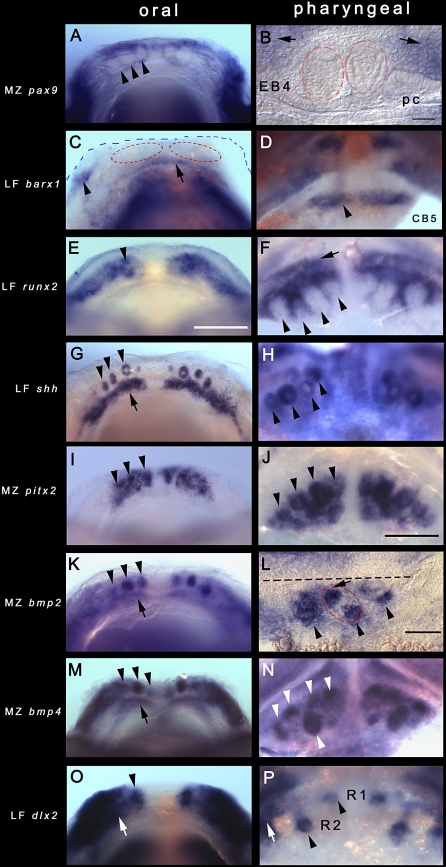
A Dental Gene Network Exhibits Conserved Expression in Oral and Pharyngeal Teeth(A, C, E, G, I, K, M, and O) show gene expression in the oral dentition, all dorsal views of the lower jaw. (D, F, H, J, N, and P) show dorsal views of the developing lower pharyngeal dentition; (B and L) are coronal sections through the pharyngeal teeth. M. zebra (MZ) (A, B, and I–N) and L. fuelleborni (LF) (C–H, O, and P) are represented here at the three to four oral tooth stage (∼6–7 dpf); the pharyngeal dentition develops ahead of the oral teeth, and so at this time point there are approximately seven pharyngeal teeth per pharyngeal quadrant.(A and B) show pax9 expression in MZ. (A) In the lower oral jaw, pax9 marks mesenchymal cells surrounding teeth (black arrowheads). (B) shows a coronal section showing upper pharyngeal teeth with pax9 lateral to (black arrows) but not associated with teeth (red dashed circles). Scale bar in (B) represents 20 μm. EB4, epibranchial 4; pc, pharyngeal cavity.(C and D) show barx1 expression in LF. (C) In the lower oral jaw (outlined in blue dashes), barx1 is expressed in a band of mesenchymal cells (black arrow) lingual to the tooth sites (red dashed regions), and also in lateral cell clusters (black arrowhead) away from tooth sites. (D) barx1 is localized to mesenchymal cells underlying tooth sites in developing lower pharyngeal jaw (CB5, black arrowhead). CB5, ceratobranchial 5.(E and F) show runx2 expression in LF. (E) runx2 labels both mesenchymal cells of the oral mesiodistal field for tooth competence and mesenchymal cells that surround the epithelial tooth germs (black arrowhead). (F) Equivalent expression is observed in the developing pharyngeal jaw (tooth germs, black arrowheads) and in tooth-competent regions of mesenchyme (black arrow).(G and H) show shh expression in LF. (G) shh is expressed in the epithelial cells of the developing oral dentition (black arrowheads; differences in expression from spots to open circles show variation in the stage of tooth development). shh also labels the epithelial odontogenic band for posterior tooth rows (black arrow). (H) shh is up-regulated in the pharyngeal dentition (black arrowheads) as in oral teeth.(I and J) show pitx2 expression in MZ. (I) pitx2 marks the dental-competent oral epithelium around the tooth sites and is up-regulated in tooth germs, from the thickened epithelium to the maturing tooth germ (black arrowheads). (J) Similarly, pitx2 labels both dental competent epithelia and epithelial tooth germs (black arrowheads) of PA7/CB5.(K and L) show bmp2 expression in MZ. (K) bmp2 is localized to the epithelial tooth thickenings (black arrowheads) and the competent epithelia along the mesiodistal axis of the oral jaw. bmp2 becomes coexpressed to both the developing epithelial (teleost enameloid cell cluster [TEC], black arrow in [L]) components and mesenchymal papilla of the tooth germs [49] and in epithelial cells in a band lingual to the first teeth (black arrow in [K]) for new tooth rows. (L) shows a coronal section of lower pharyngeal teeth; bmp2 labels both the epithelial cells of the TEC (black arrow) and mesenchymal cells of the dental papilla (black arrowhead) of the same tooth (red dashed circle). In epithelial thickenings, bmp2 is present in the thickened epithelial cells and is also expressed in the condensing cells of the underlying mesenchyme (black arrowheads). The black dashed line indicates the pharyngeal cavity. Scale bar in (L) represents 50 μm.(M and N) show bmp4 expression in MZ. (M) In the oral jaw (OJ) and (N) the pharyngeal jaw (PJ), bmp4 is expressed in dental epithelial cells of tooth germs (OJ, black arrowheads; PJ, white arrowheads); later, bmp4 is coexpressed in the mesenchymal cells of the dental papilla. Along the mesiodistal axis of the oral jaw, bmp4 labels the mesenchymal field of dental competence, and for new tooth rows lingually (black arrow). In addition, bmp4 is expressed throughout the pharyngeal arch mesenchyme (see also Figure 1E and 1F).(O and P) show dlx2 expression in LF. dlx2 labels the first tooth (in the series) for each tooth row in both the oral jaw (PA1, black arrowhead in [O]) and the pharyngeal jaw (PA7, black arrowheads in [P]). dlx2 is also present in the mesenchymal cells along the mesiodistal axis of the oral jaw and pharyngeal jaw (white arrows). (P) The black arrowheads show new row initiation. R1, row 1; R2, row 2.(A, C, E, G, I, K, M, and O) are all to the same scale. Scale bar in (E) represents 100 μm. (D, F, H, J, N, and P) are all to the same scale. Scale bar in (J) represents 100 μm.For details of expression in thin section for most of these markers, see [49].